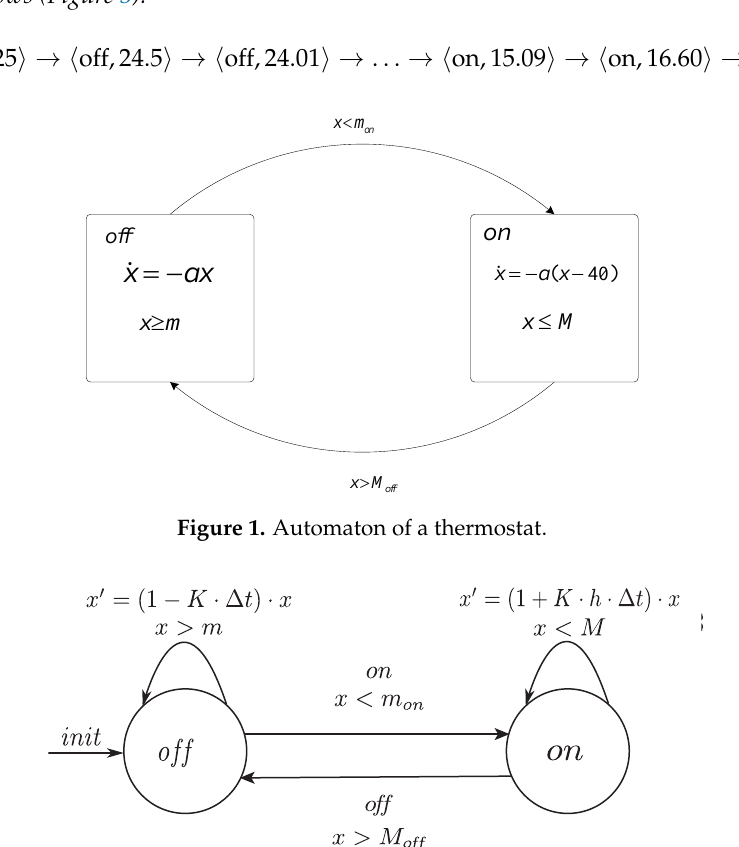
Fig. 1: A thermostat